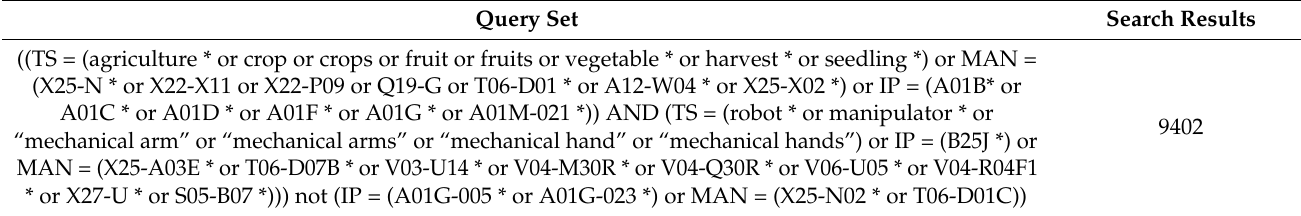
Table 1. Agricultural robot patent query set, where TS is the topic terms in the Title and Abstract fields within a patent record, MAN is the Derwent Manual Code(s) field within a patent record, and the IP is the International Patent Classification (IPC) field within a patent record, * is the wildcard. Query Set Search Results ((TS = (agriculture * or crop or crops or fruit or fruits or vegetable * or harvest * or seedling *) or MAN = (X25-N * or X22-X11 or X22-P09 or Q19-G or T06-D01 * or A12-W04 * or X25-X02 *) or IP = (A01B* or A01C * or A01D * or A01F * or A01G * or A01M-021 *)) AND (TS = (robot * or manipulator * or “mechanical arm” or “mechanical arms” or “mechanical hand” or “mechanical hands”) or IP = (B25J *) or MAN = (X25-A03E * or T06-D07B * or V03-U14 * or V04-M30R * or V04-Q30R * or V06-U05 * or V04-R04F1 * or X27-U * or S05-B07 *))) not (IP = (A01G-005 * or A01G-023 *) or MAN = (X25-N02 * or